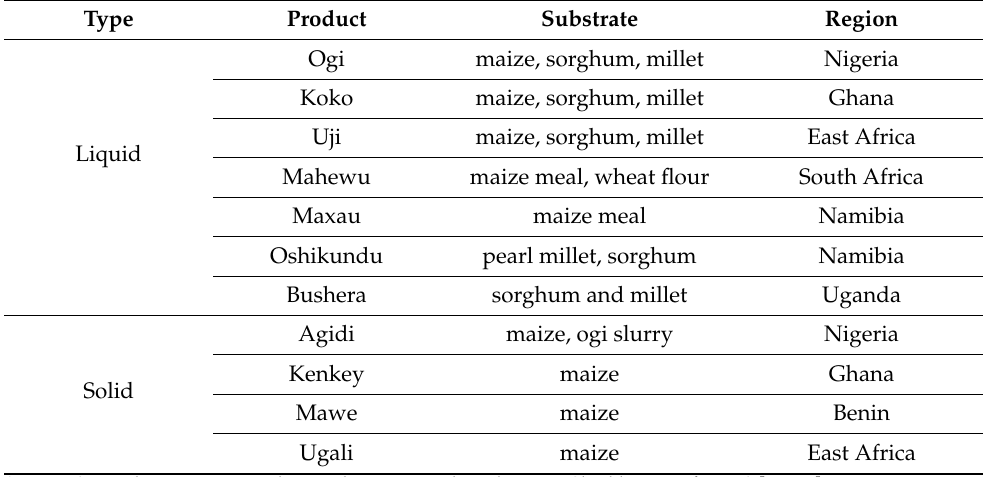
Table 2. Some African traditionally produced fermented and non-fermented cereal-based foods. Type